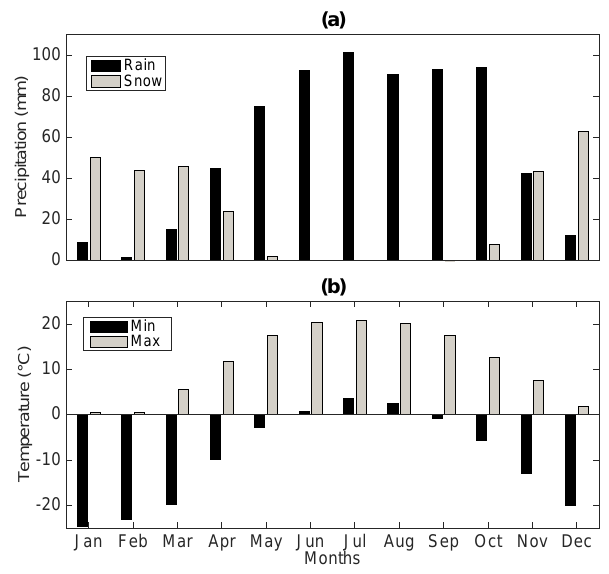
Figure 2. Monthly average values for (a) precipitation and (b) tem- perature for the Montmorency River